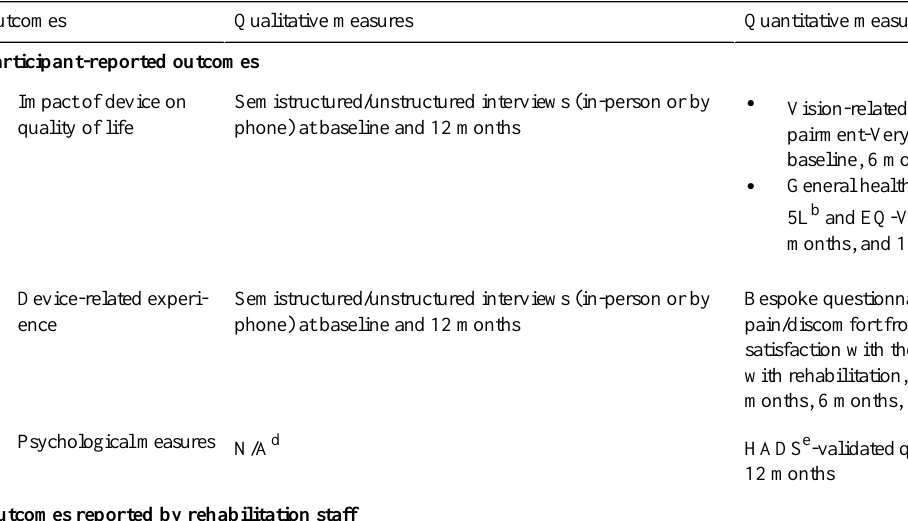
Quantitative measuresQualitative measuresOutcomes